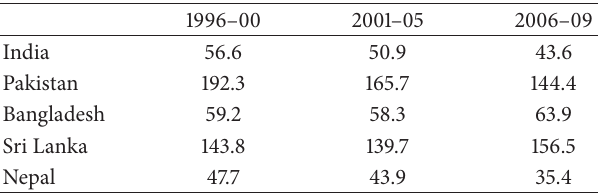
Table 1: Number of full-time equivalent agricultural researchers per million economically active agricultural populations in selected South Asian countries,